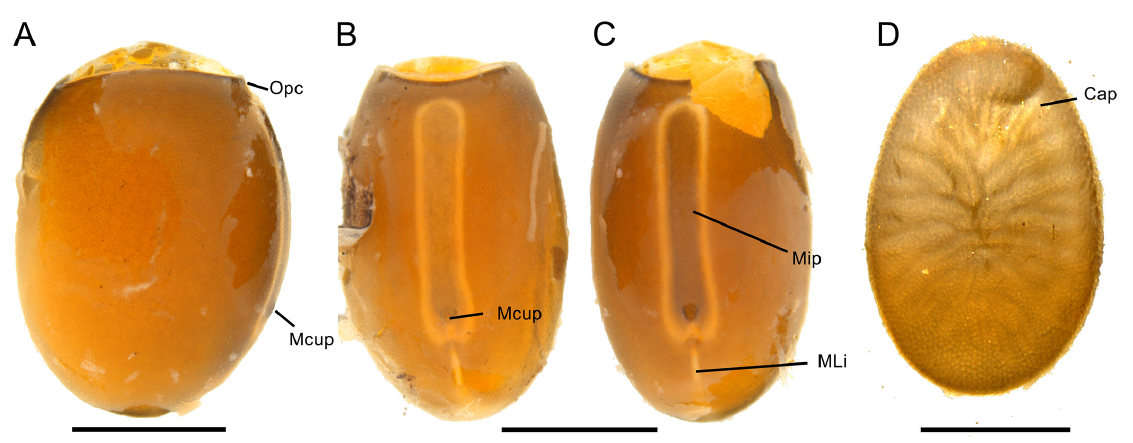
Fig. 51. Arumatia diamante Ghirotto gen. et sp. nov., egg morphology from the holotype female. A . Lateral view. B–C . Dorsal view. D . Detail of operculum, anterior view. Abbreviations: Cap = capitulum; Mcup = micropylar cup; Mip = micropylar plate; MLi = median line; Opc = operculum. Scale bars: A–C = 1 mm; D = 0.5